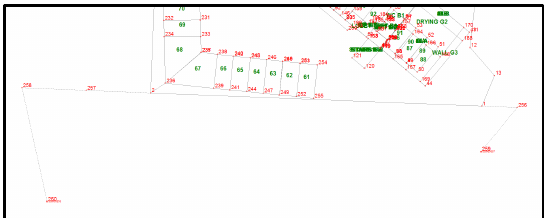
Figure 3: Capture of survey control and connection lines